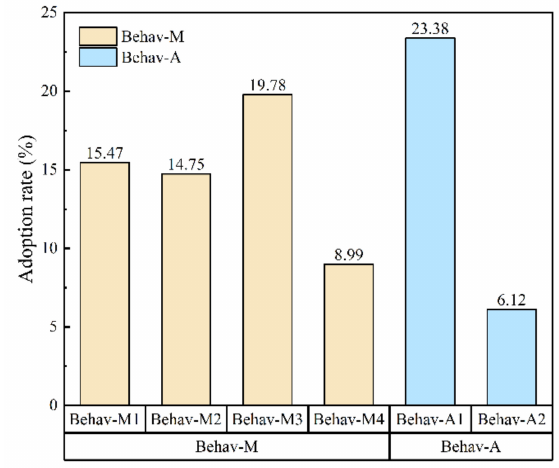
Figure 3. Farmers’ adaptive behaviors to heavy metal pollution in cultivated land.